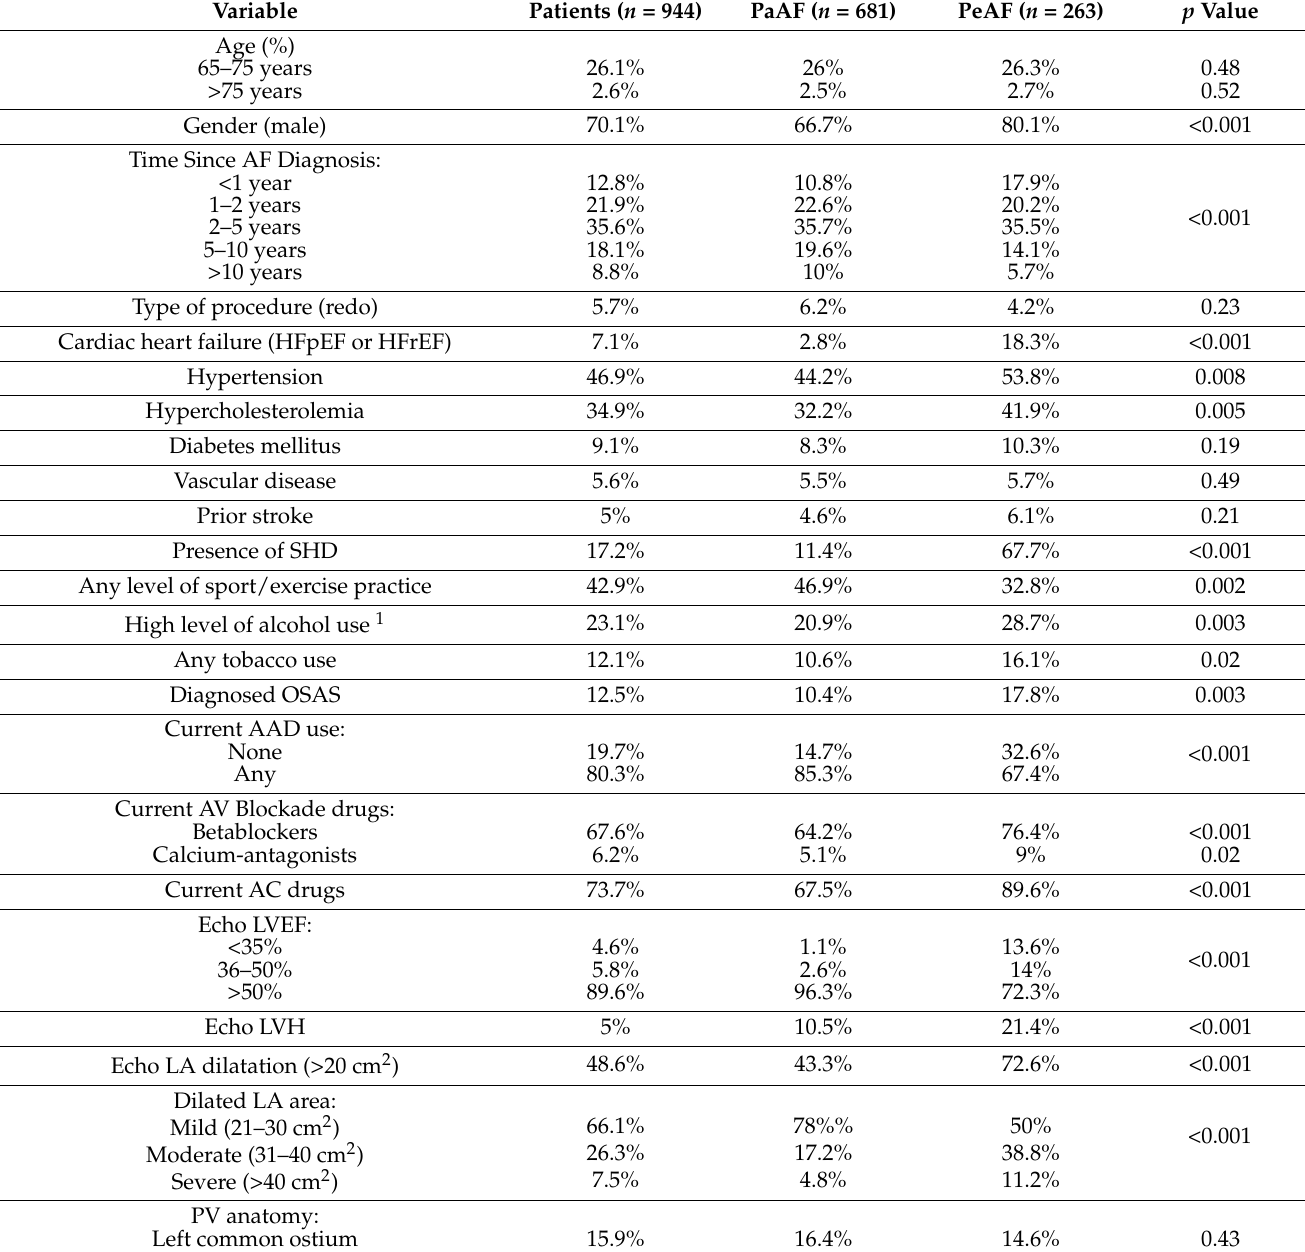
Table 1. Clinical and Anatomical Characteristics: Paroxysmal vs.